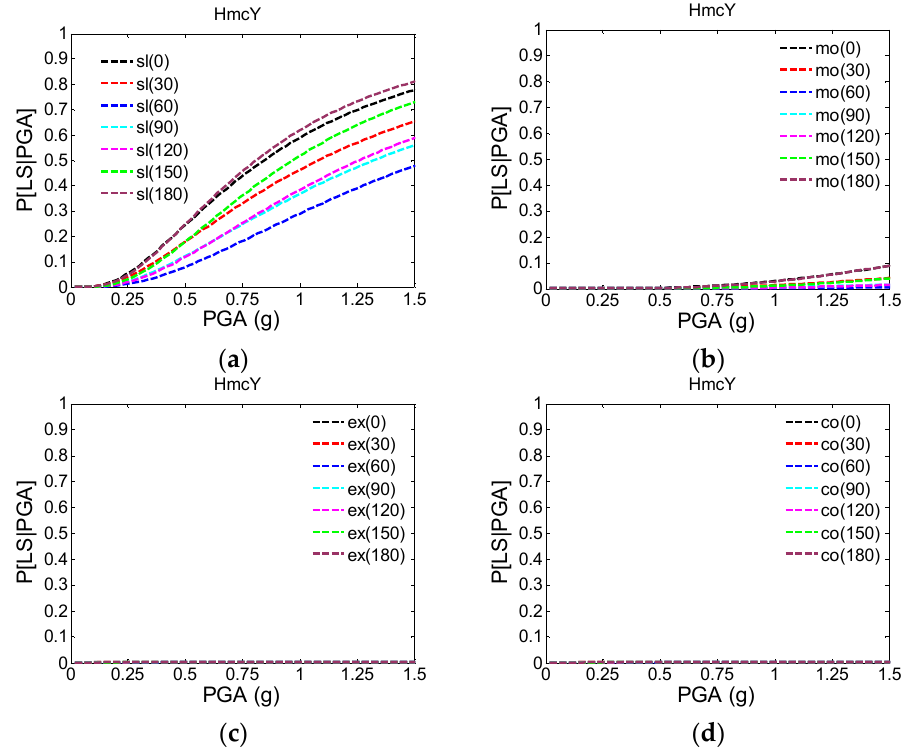
Figure 8. Seismic fragility curves of HmcY subjected to different excitation angles in the ( a ) slight; ( b ) moderate; ( c ) extensive; and ( d ) complete limit states.